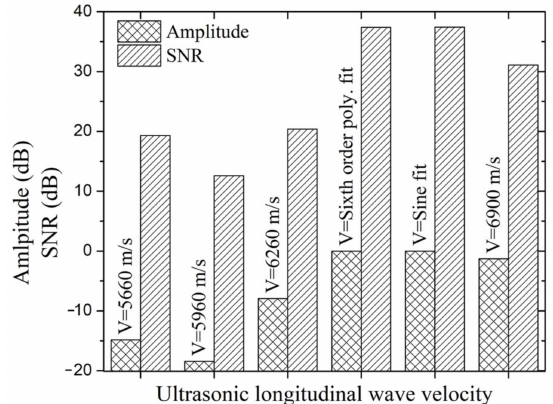
Figure 7. Amplitude and signal-to-noise ratio (SNR) obtained for third SDH in the TFM images processed with isotropic and angle dependent ultrasonic velocity values as shown in Figure 6. The amplitude values are normalized with respect to that of the same SDH in the TFM image processed with angle dependent velocity obtained using sixth-order polynomial